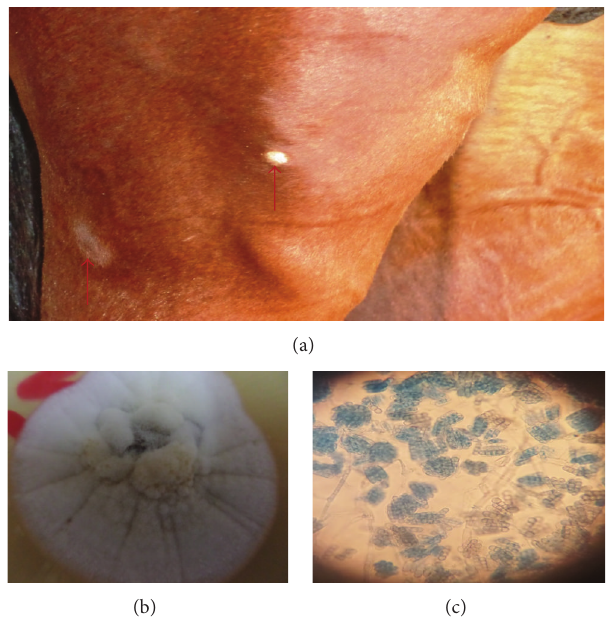
Figure 6: Discrete, raised areas of crusting (a), progressing to areas of patchy alopecia on the girth region of a horse caused by M. equinum (b), downy colony of M. equinum (c), and two-celled thick walled spindle shaped macroconidia of M. equinum